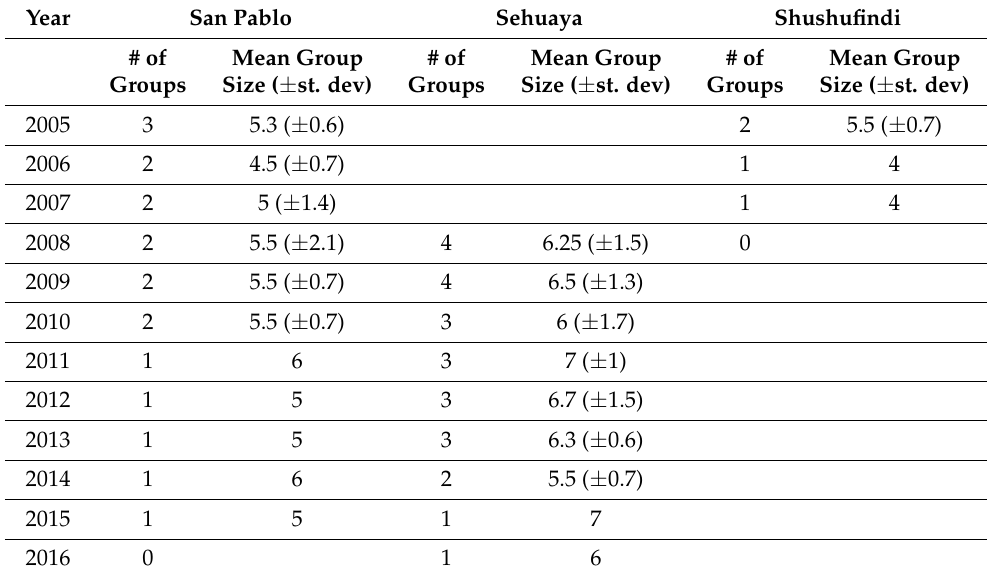
Table 1. Number of groups and mean group size ( ± st. dev) of Western pygmy marmoset Cebuella pygmaea in three sites (San Pablo, Sehuaya, and Shushufindi) of the Secoya territory from 2005 to 2016.